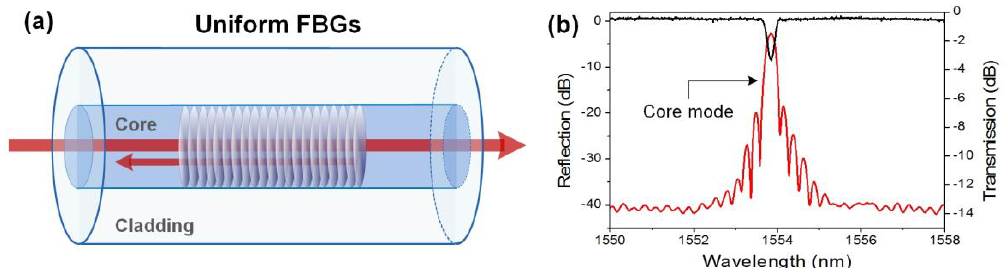
Figure 2. ( a ) Sketch of the light mode coupling in a uniform fiber Bragg grating (FBG); and ( b ) transmitted (black curve)/reflected (red curve) amplitude spectra of a 1 cm long uniform